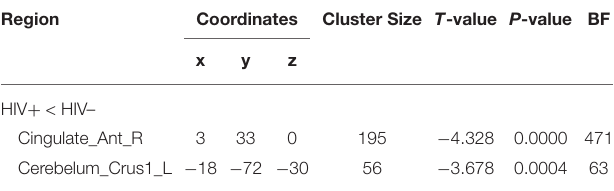
TABLE 5 | Regional homogeneity differences between HIV + HoM and HIV– HoM.